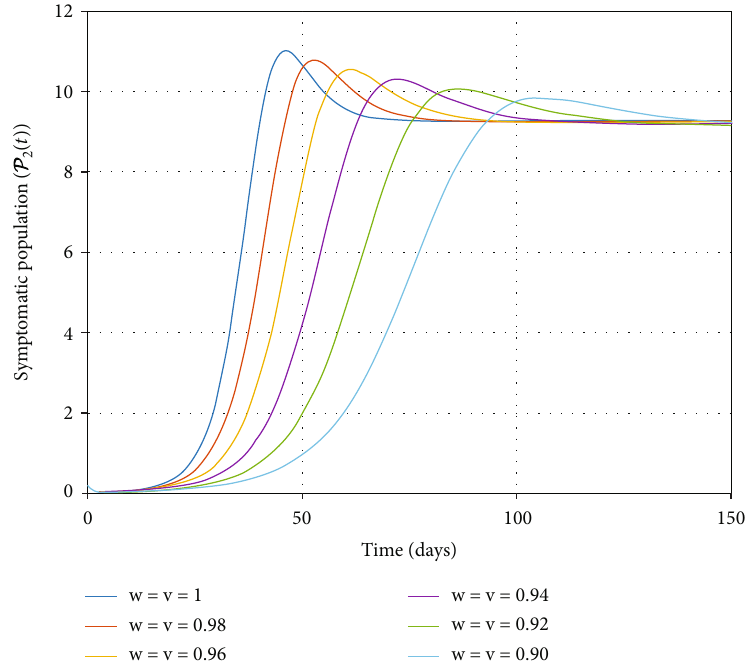
Figure 6: Behavior of P